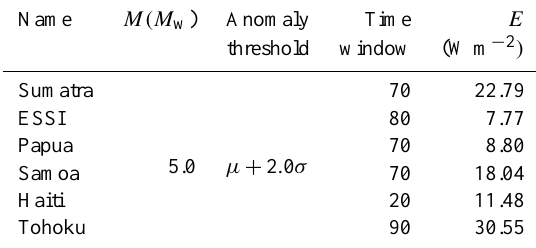
years, including the study period, plus 2.0 times the standard deviation (i.e., µ + 2 . 0 σ) .